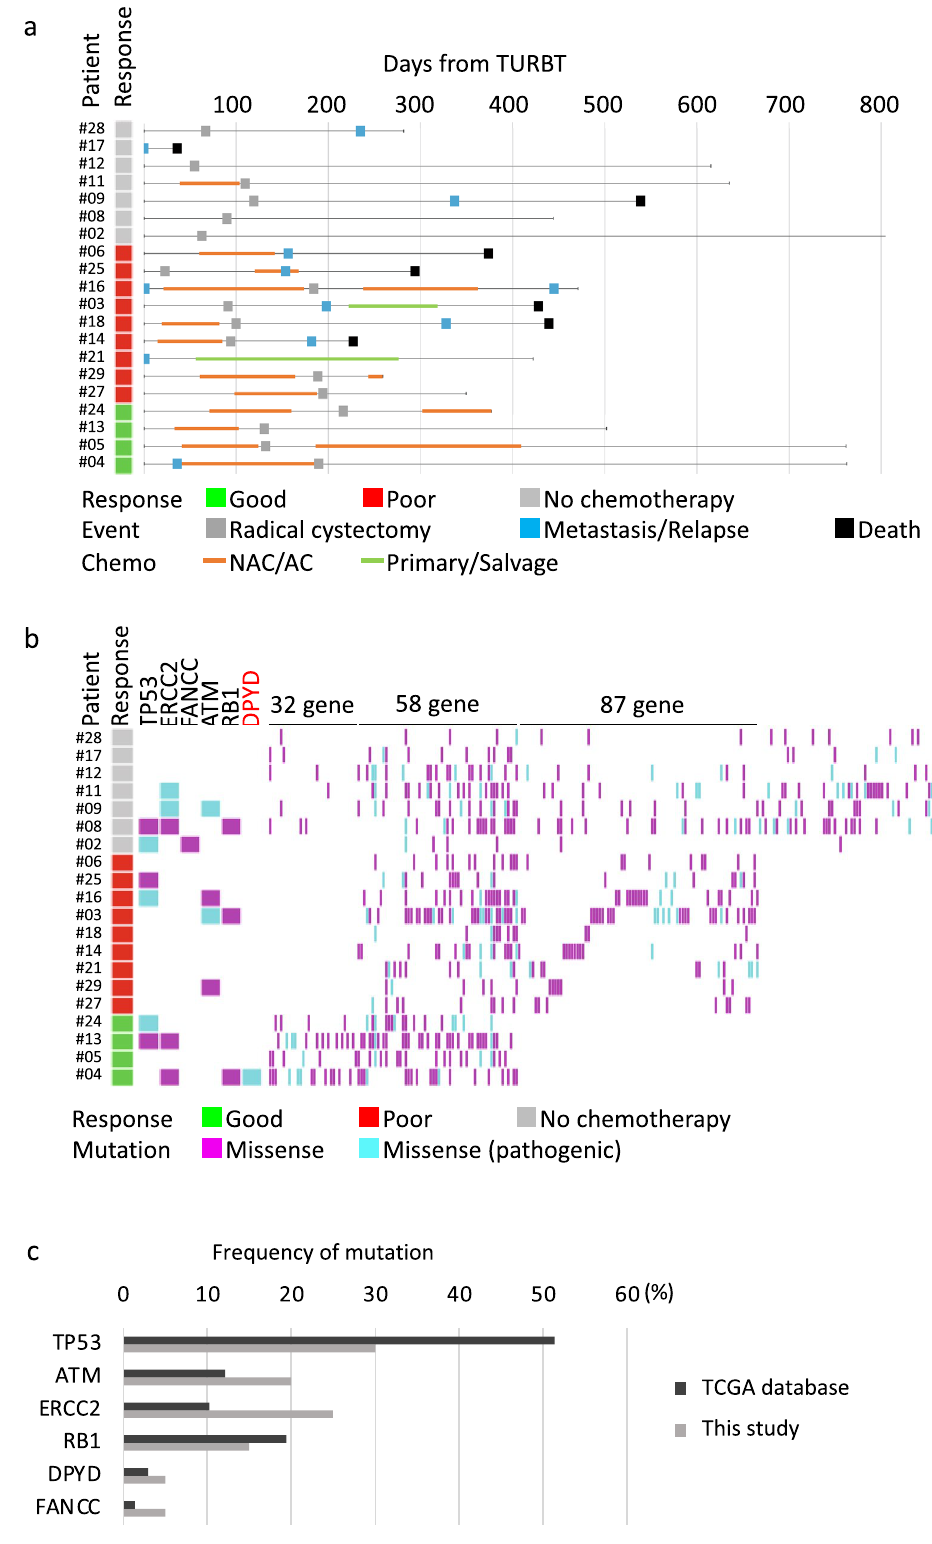
Figure 1. Clinical course and mutation landscape in 20 patients with BC. ( a ) Swimmers’ plot of 20 patients from TURBT. Tumor response to chemotherapy, events, and purpose of chemotherapy are shown. NAC, neoadjuvant chemotherapy; AC, adjuvant chemotherapy. ( b ) Overview of genomic mutations detected in 20 patients with MIBC. Deleterious missense mutations were colored light blue. Genomic alterations in TP53 , ERCC2 , FANCC , ATM , RB1 , and DPYD were shown. RC, radical cystectomy. ( c ) Frequency of genomic alterations ( TP53 , ERCC2 , FANCC , ATM , RB1 , and DPYD ) detected in this study (gray bar) and TCGA database (black bar) were